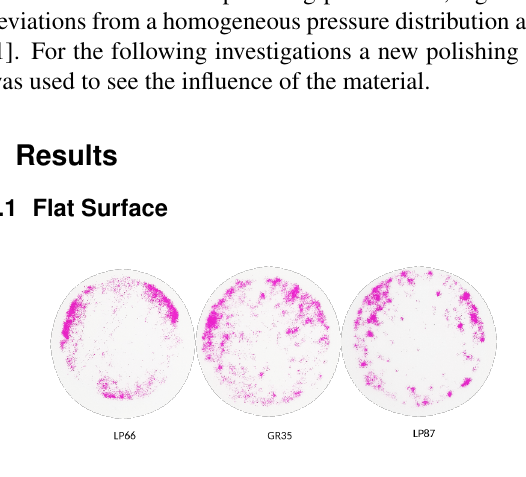
Figure 3. Discoloration of the fi lm after pressure loading on a non-tilted surface.